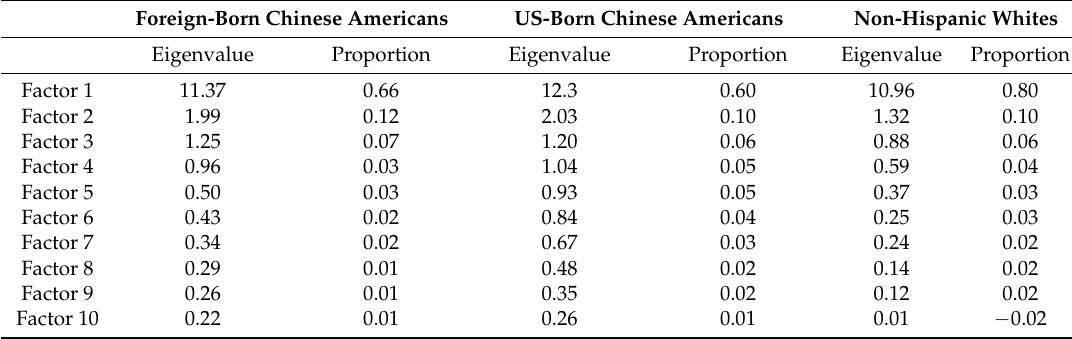
Table 2. Eigenvalues of First Ten Factors from Initial Factor Analysis.